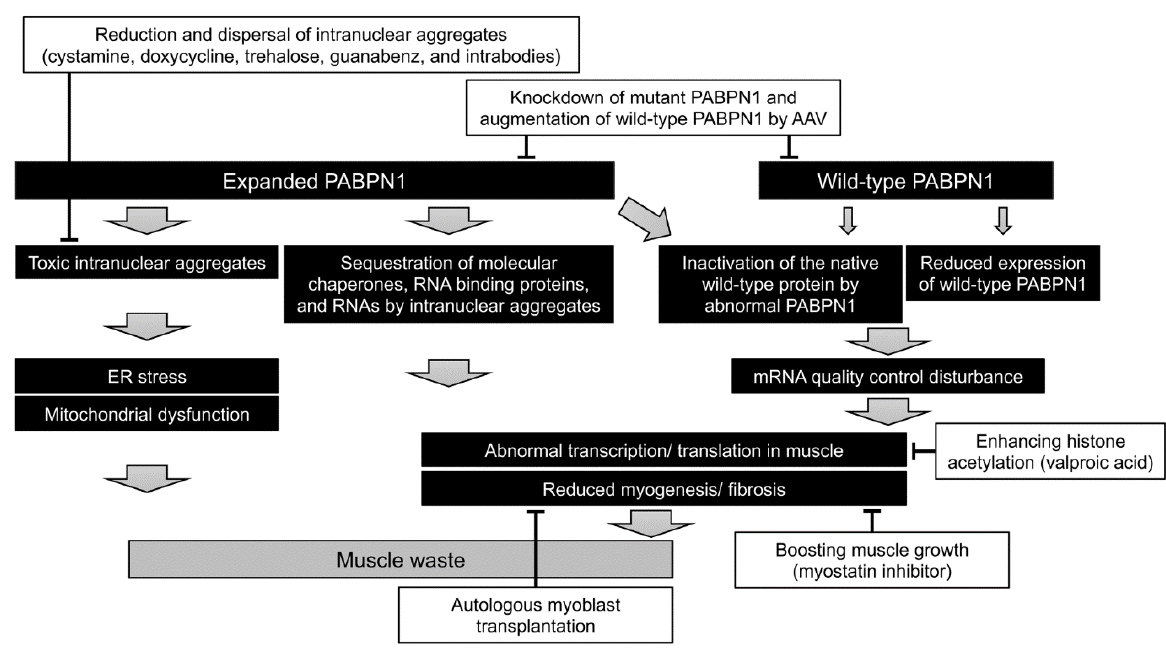
Figure 2. Pathogenesis and therapeutic approach for OPMD. Several therapeutic strategies have been proposed based on the pathogenesis of OPMD, such as (1) knockdown of mutant PABPN1 and/or augmentation of wild-type PABPN1 using adeno-associated virus (AAV) vectors; (2) boosting muscle growth using myostatin inhibitor; (3) reduction and dispersal of intranuclear aggregates using cystamine, doxycycline, trehalose, guanabenz, and intrabodies; and (4) autologous myoblast transplantation combined with cricopharyngeal